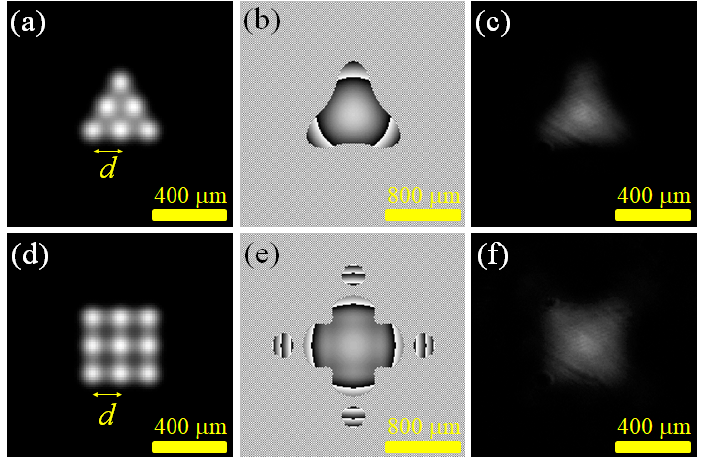
Figure 4. Experiments of generating triangular and rectangular laser light fields: ( a ) the calculated 6-point light field intensity; ( b ) the SLM projected phase diagram for generating a triangle light field; ( c ) the resulting triangle field distributions; ( d ) the calculated 9-point light field intensity; ( e ) the SLM projected phase diagram for generating a rectangle light field; ( f ) the resulting rectangle field distributions.